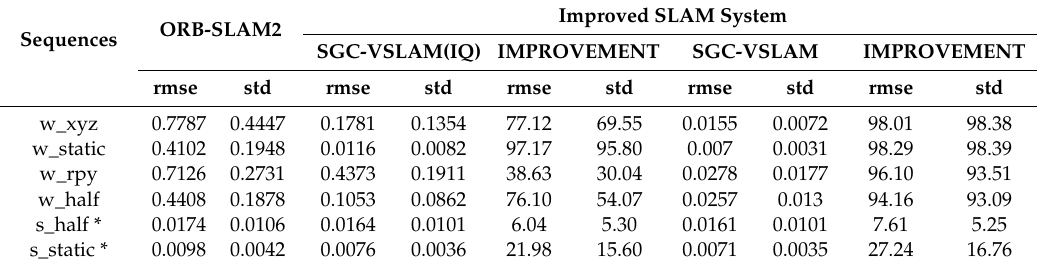
Table 1. Experimental results of the absolute trajectory error.